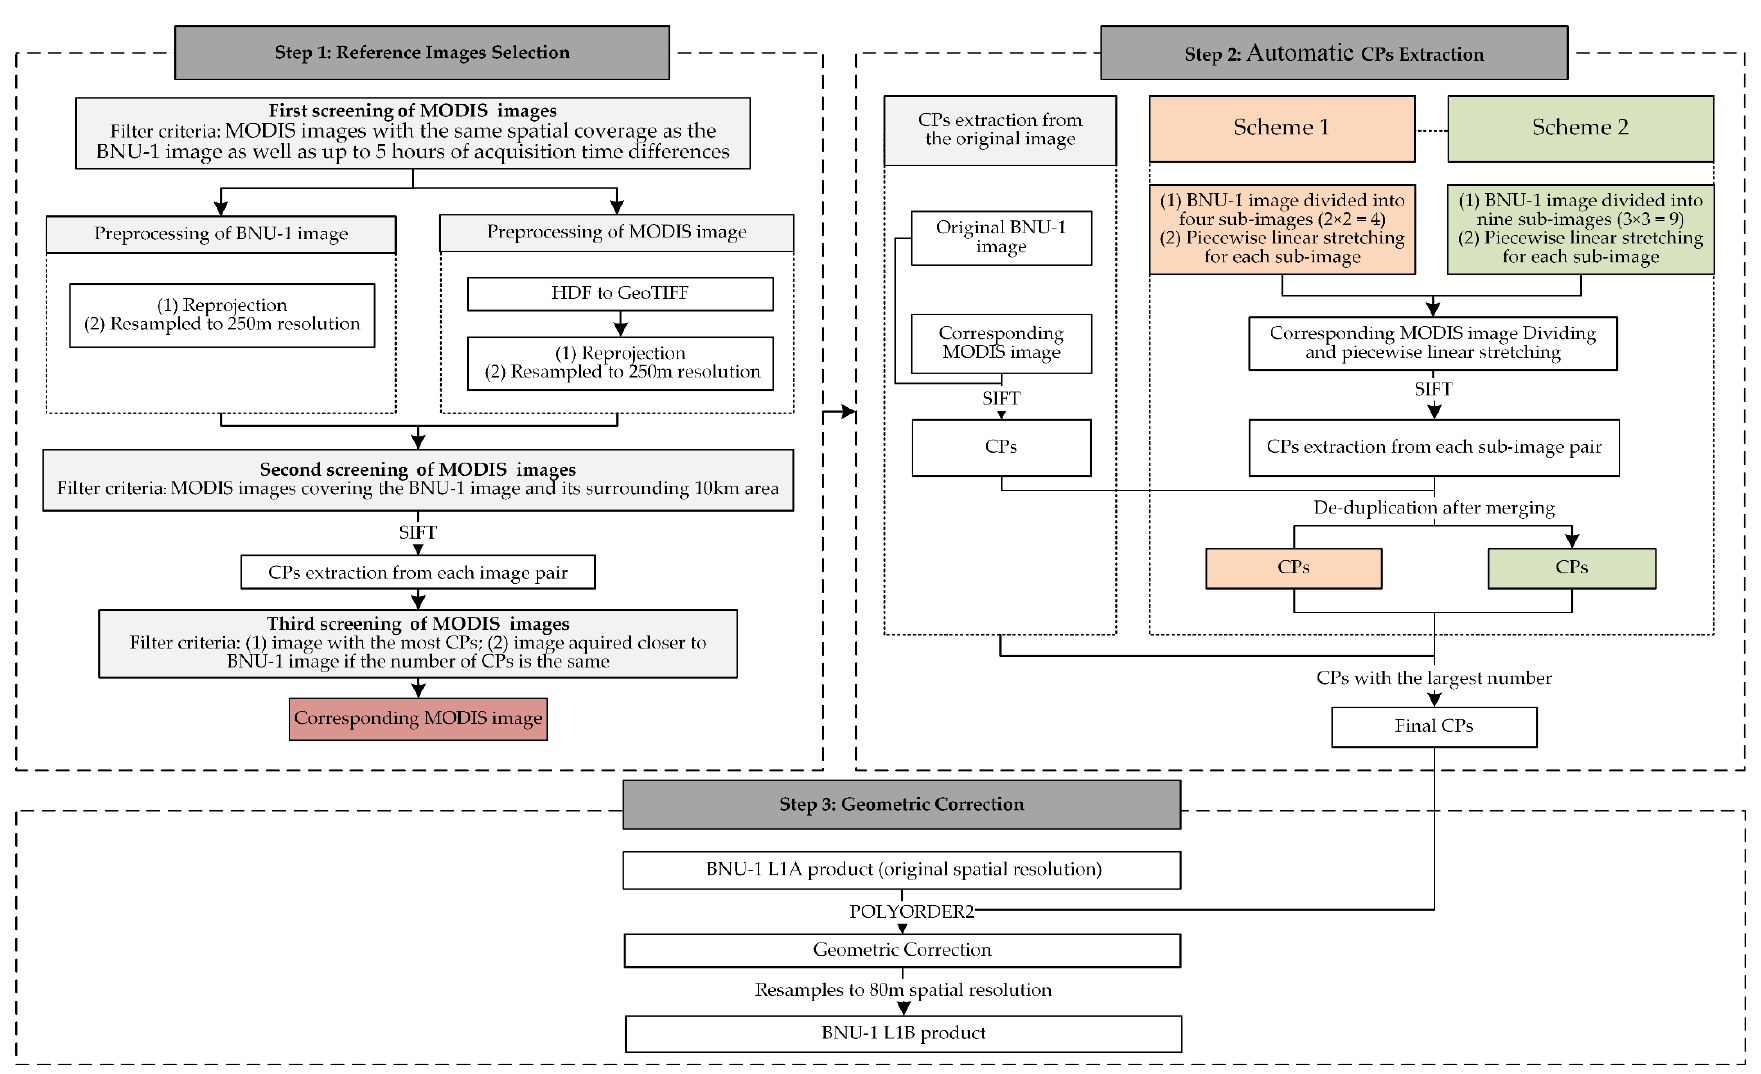
Figure 2. The flowchart for the automated geometric correction processing method of BNU-1 L1A product.